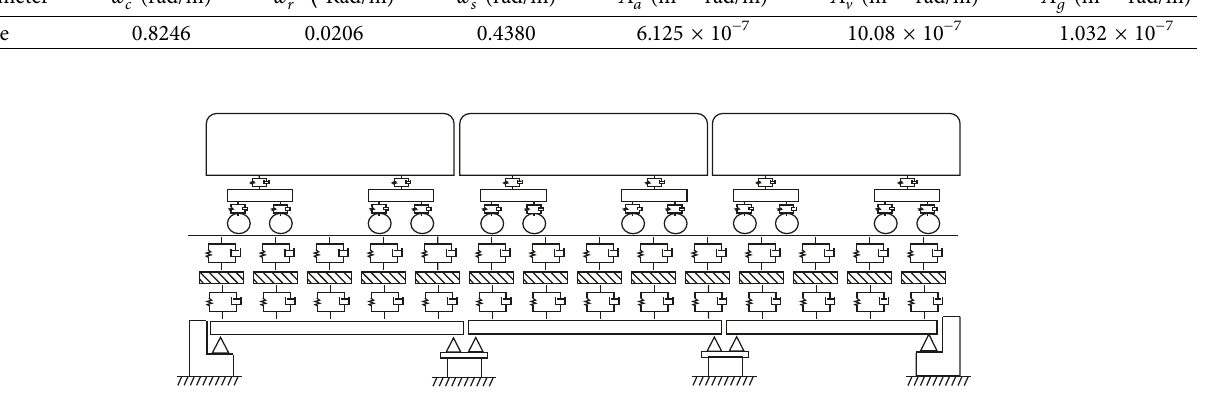
Figure 7: The model of the vehicle-track-bridge coupled